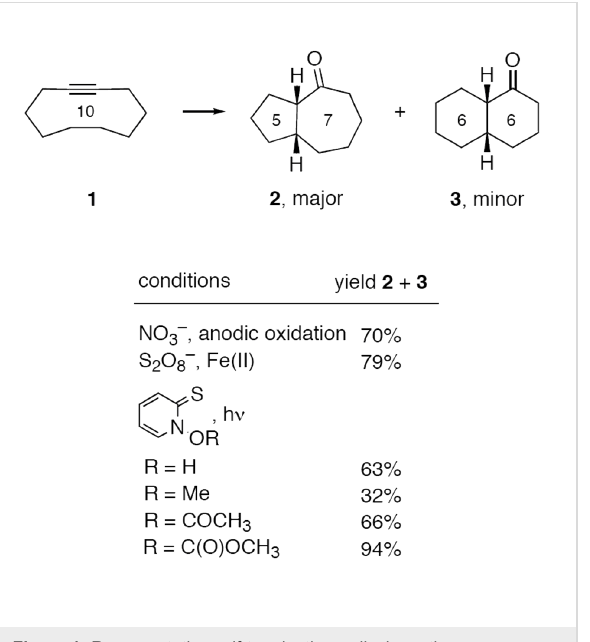
Figure 1: Representative self-terminating radical reactions.